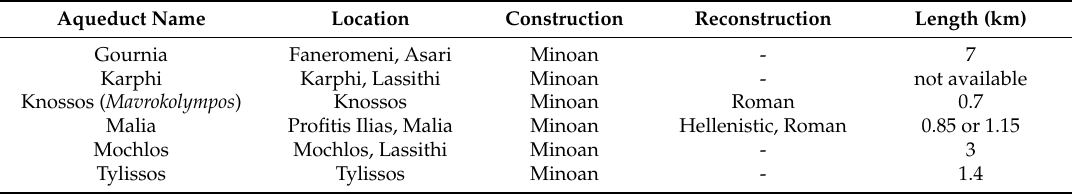
Table 2. Characteristics of major aqueducts in Minoan Crete [7].